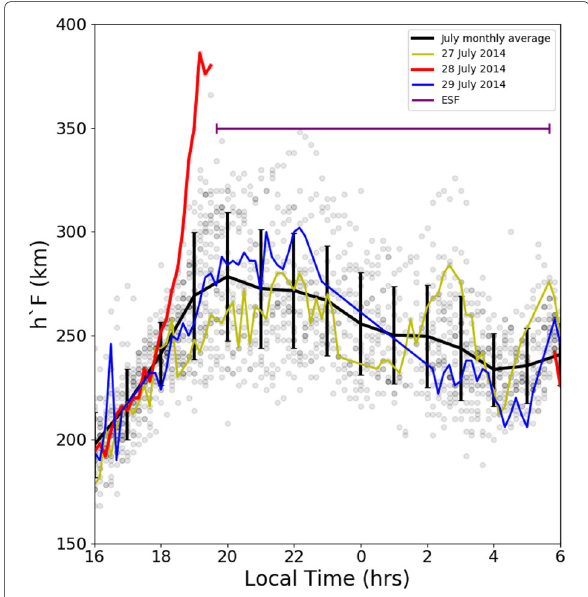
Fig. 6 The hourly average of h’F versus local time throughout July 2014 (black, error bars indicate ± 1 standard deviation) and the h’F versus local time for 27 (yellow), 28 (red), and 29 (blue) July 2014, as measured by the BCL ionosonde. The horiztonal bar indicates the presence of spread F on 28